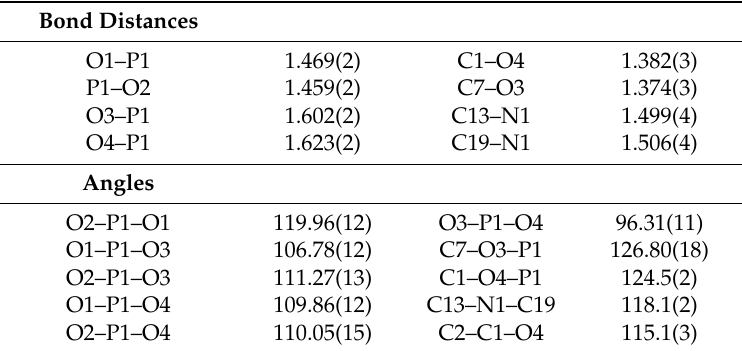
Figure 1. The structure of [(C 6 H 11 ) 2 NH 2 ][(C 6 H 5 O) 2 P(O)(O)], showing the atom-numbering scheme for non-hydrogen atoms and displacement ellipsoids at the 50% probability level. Hydrogen atoms are drawn as spheres of arbitrary radii. Table 1. Selected bond distances (Å) and angles (°).